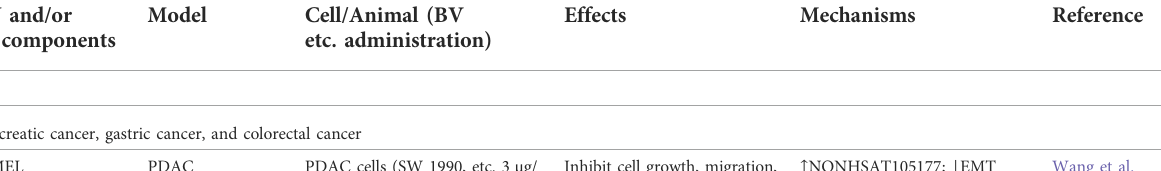
TABLE 1 ( Continued ) Summary of the anti-cancer effects and mechanisms of BV and its main